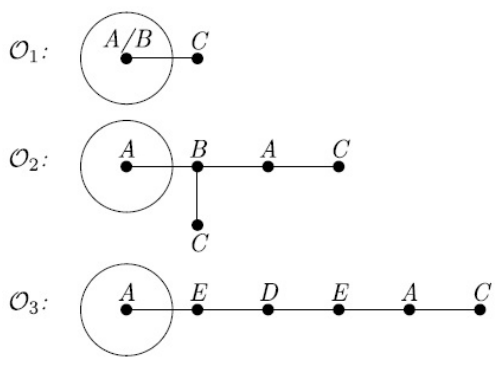
Figure 6. Vertex status of A, B, C, D, E and the three Operations